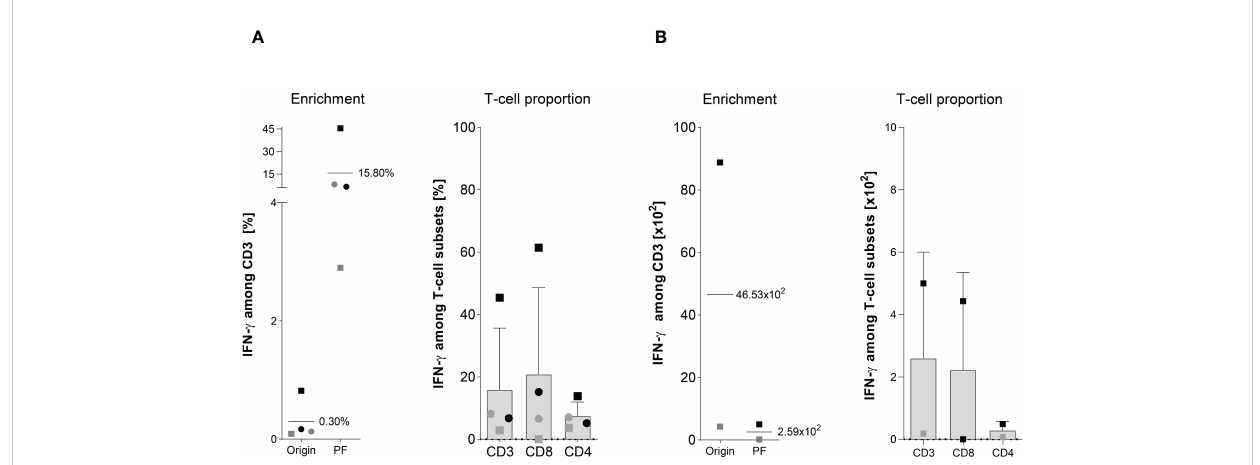
FIGURE 3 Magnetically enrichment of PepMix-stimulated ATCs. The enrichment ef fi ciency of in vitro stimulated Asp-speci fi c T cells was assessed by magnetic selection using the IFN- g cytokine secretion assay (CSA). 1 x 10 7 isolated PBMCs were stimulated overnight with the pooled overlapping peptide pools from Asp and Candida albicans -(PepMix: CatB, Crf1, f22, Gel1, pmp20, SHMT, SOD and MP65) each pool at a fi nal consternation of 1 µg per peptide/ml while unstimulated PBMCs served as the negative control. Aliquots of the respective cell fractions collected before (original fraction, Origin) and after enrichment (positive fraction, PF) were used for detailed characterization of activated T-cell subsets by multicolor fl ow cytometry. (A) Frequency of IFN- g + Asp-speci fi c CD3 + T cells before (Origin) and after magnetic selection (PF) and the proportion of IFN- g + Asp-speci fi c T-cells among CD3, CD4 and CD8 T cells after magnetic enrichment in the PF are shown. Results are displayed as individual results (n=4) and mean±SD. (B) Absolut cell numbers of IFN- g + Asp-speci fi c CD3 + T-cells and among the different subsets (CD3, CD8 and CD4) are shown for two experiments, as insuf fi cient cell counts after enrichment did not permit further analyses visualized by the respective mean±SD. Squares and circles represent the same individuals of our healthy donor cohort